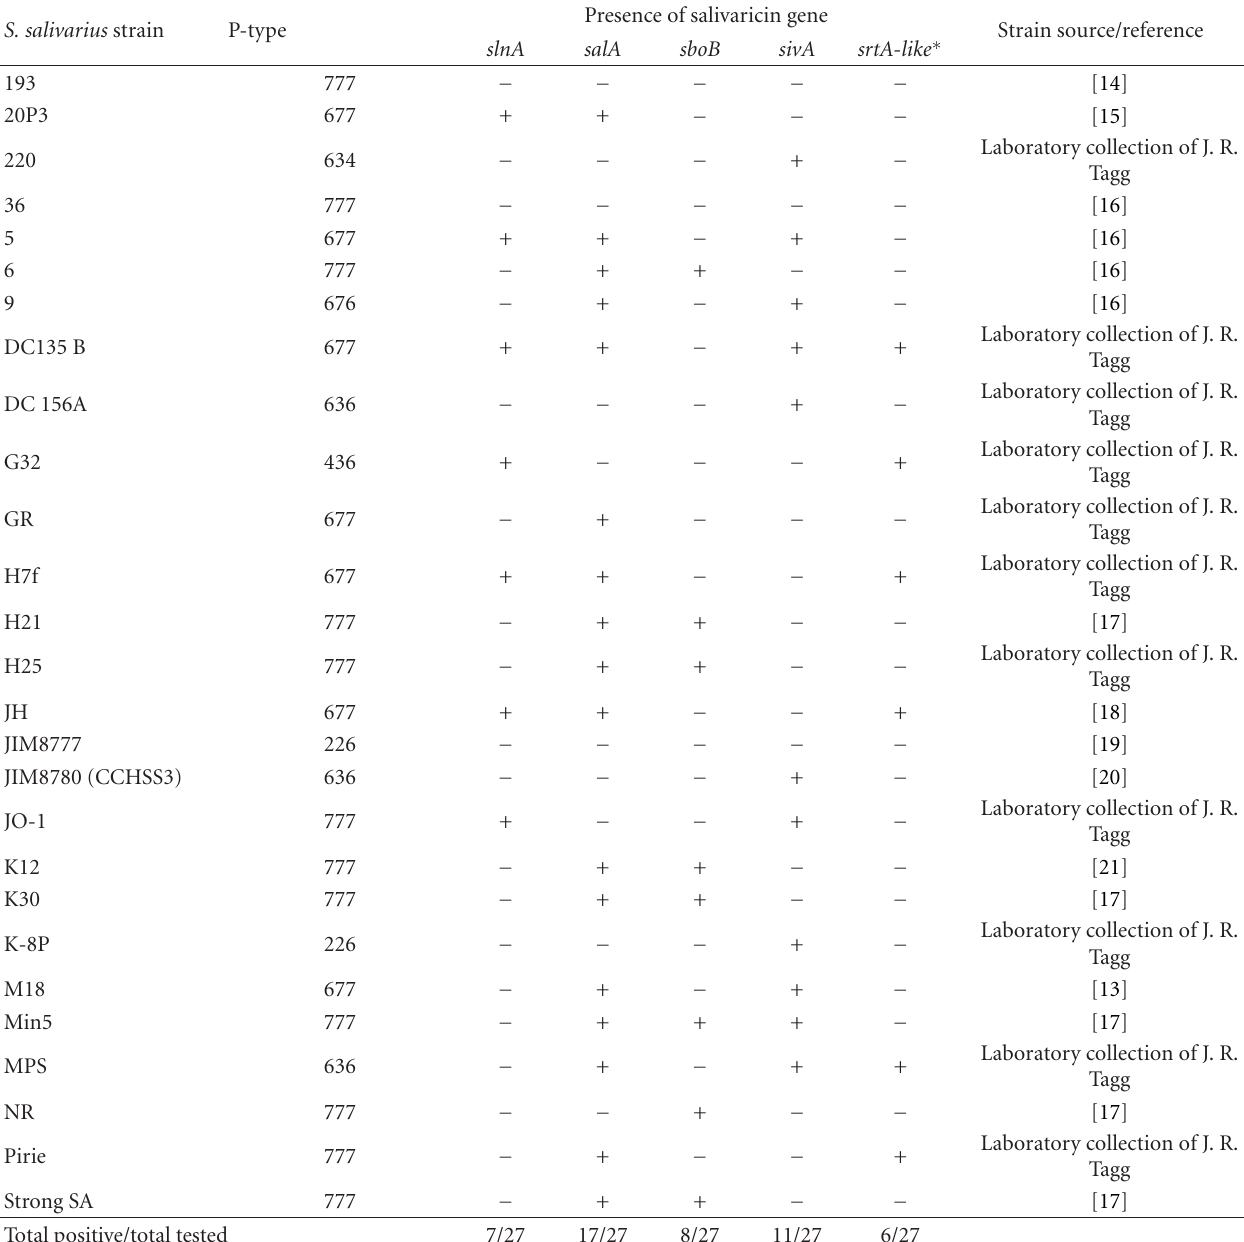
Table 2: Distribution of S. salivarius lantibiotic structural genes in S. salivarius strains of di ff erent P-type designations. S. salivarius